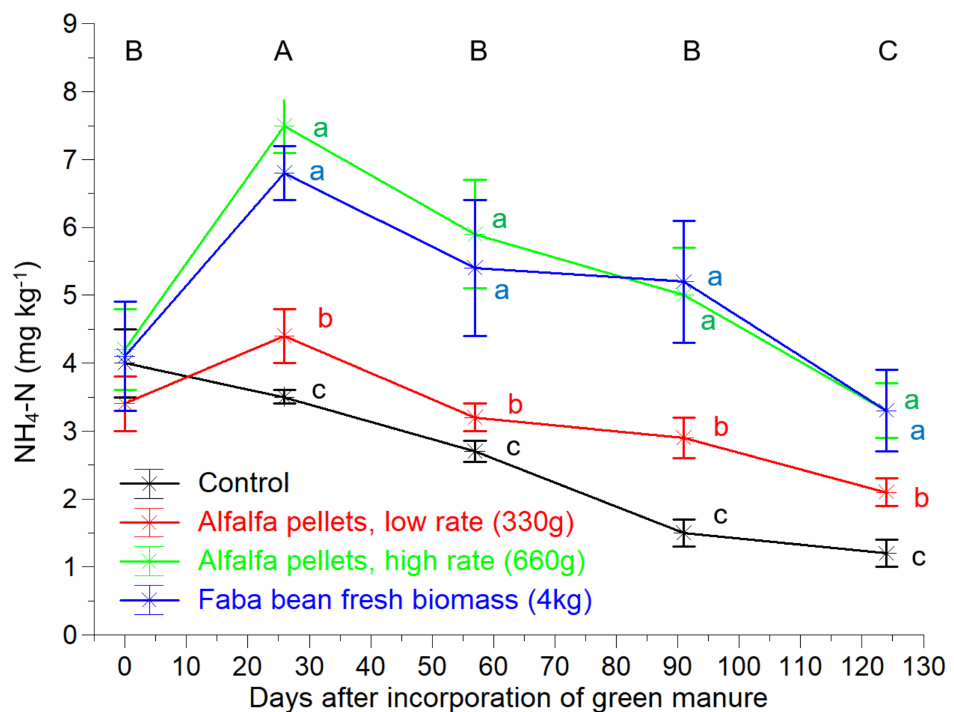
Figure 2. Soil NH 4 -N concentrations in an organic greenhouse crop of tomatoes as influenced by different treatments of mobile green manure. The vertical bars represent ± standard errors of means. The different lowercase and capital letters indicate significant differences between the treatments and sampling dates, respectively, according to the Duncan’s multiple range test ( p < 0.05).